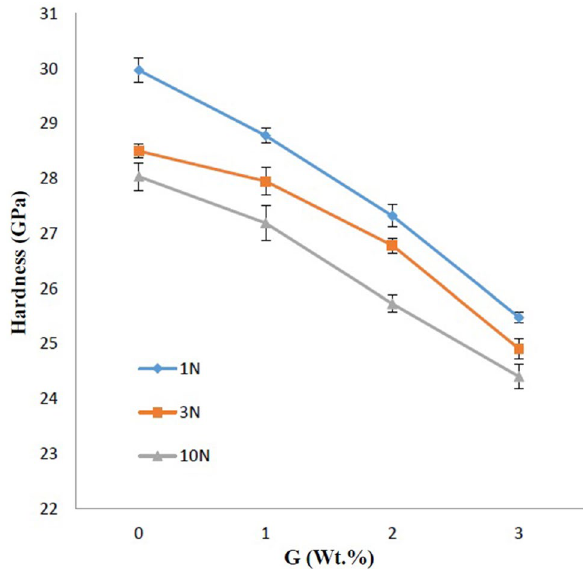
Figure 6. The effect of different loads on